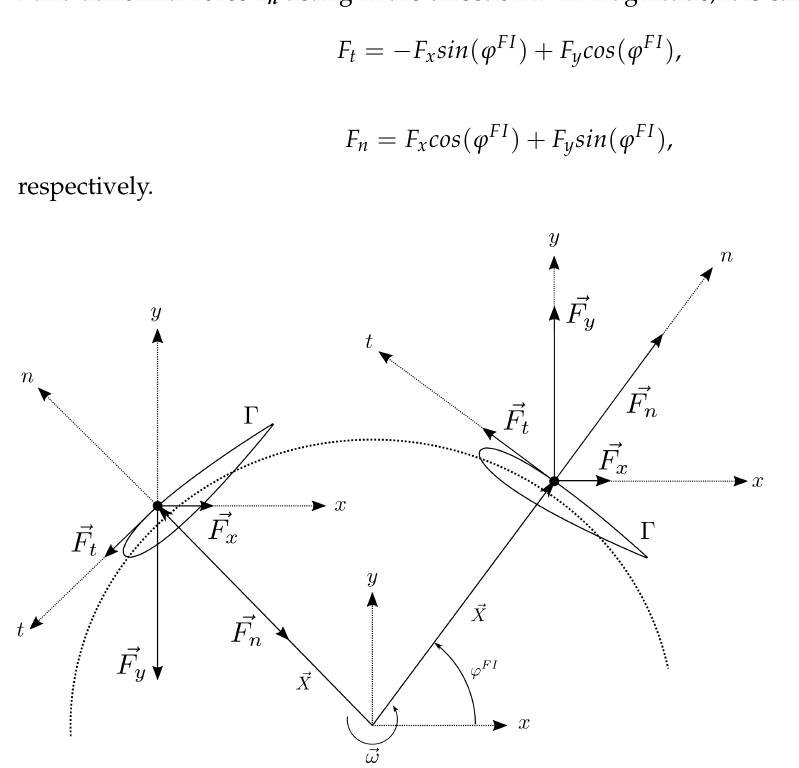
Figure 4. Decomposition of the components of the Lagrangian force: tangential force F t and normal force F n applied to a Lagrangian